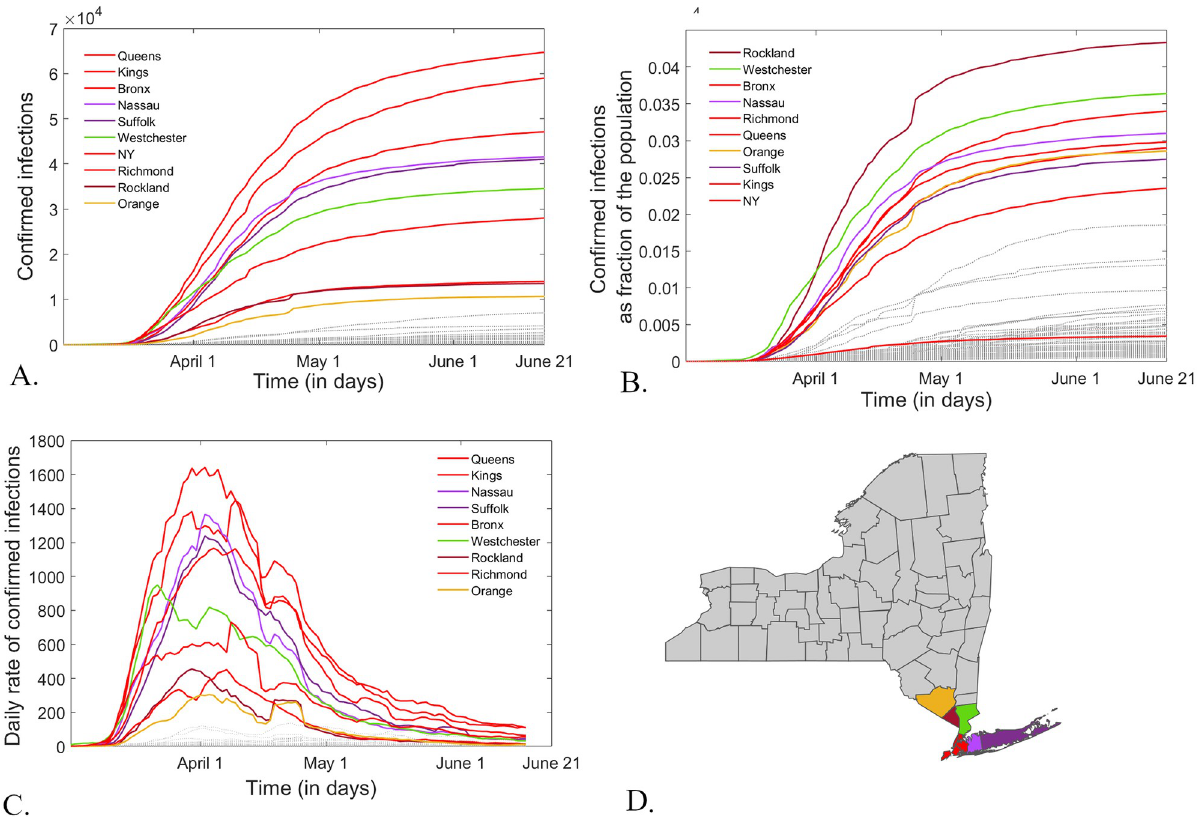
Fig 3. Infection time course in New York counties from March 1 until June 20, 2020. A. Cumulative incidence of COVID-19 infections; B. Cumulative incidence normalized by the county population size (reported as a percent). The counties with the highest cumulative incidence by June 21 are emphasized as solid curves, and labeled top to bottom in the legend. The rest of the counties, with lower incidence, are shown as faded dotted lines, for comparison . C. Smoothed time series for daily incidence of COVID-19 in New York counties form May 1 until June 20, 2020. The counties with the highest daily incidence by June 20 are labeled and emphasized as solid curves. The rest of the counties, with lower daily incidence, are shown as faded dotted lines, for comparison . D. Locations of the high infection counties from panels A, B and C, shown on the New York state map with the same color coding